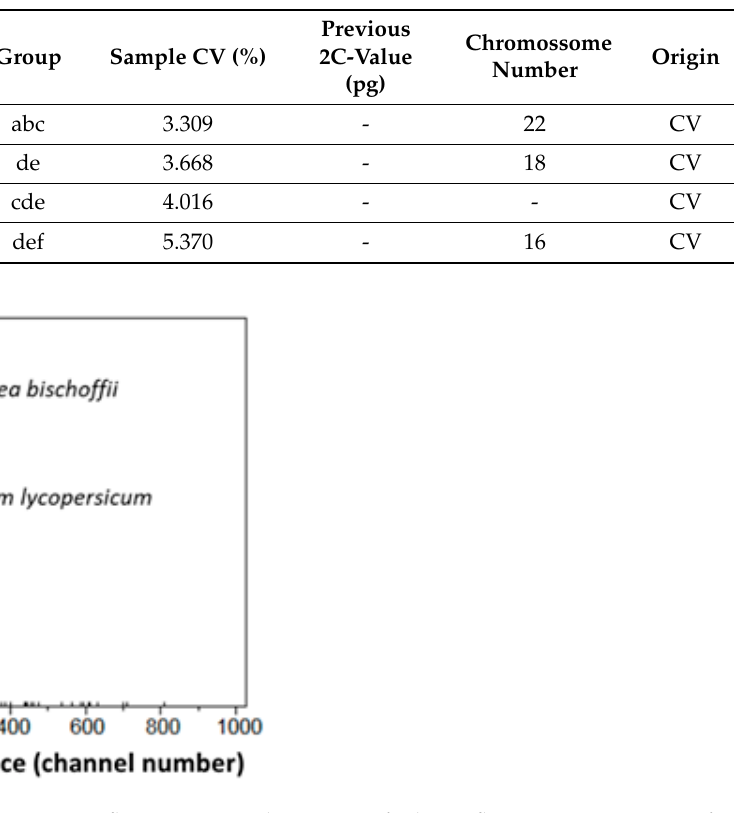
Figure 2. Flow cytometry output: flow cytometric histogram of relative fluorescence intensities from propidium iodide-stained Tornabenea bischoffii nuclei using Solanum lycopersicum (2C-values = 1.96 pg) as an internal reference standard.